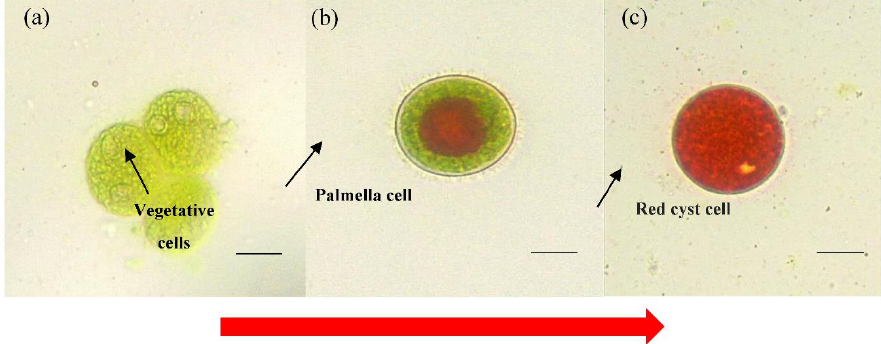
Figure 2. Light microscopic images of cells H. lacustris morphology to observe the astaxanthin accumulation ( a ) vegetative cells, ( b ) astaxanthin-accumulating, ( c ) red cyst cell. Scale bar: 10 µm [1].